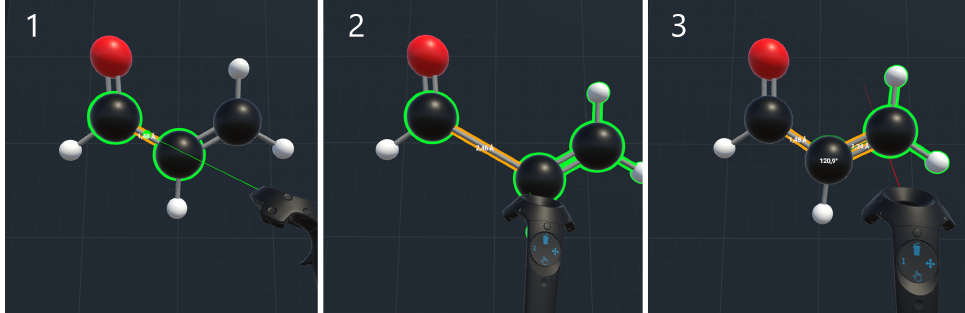
Figure 8. All atoms and bonds can be removed by using a menu button.